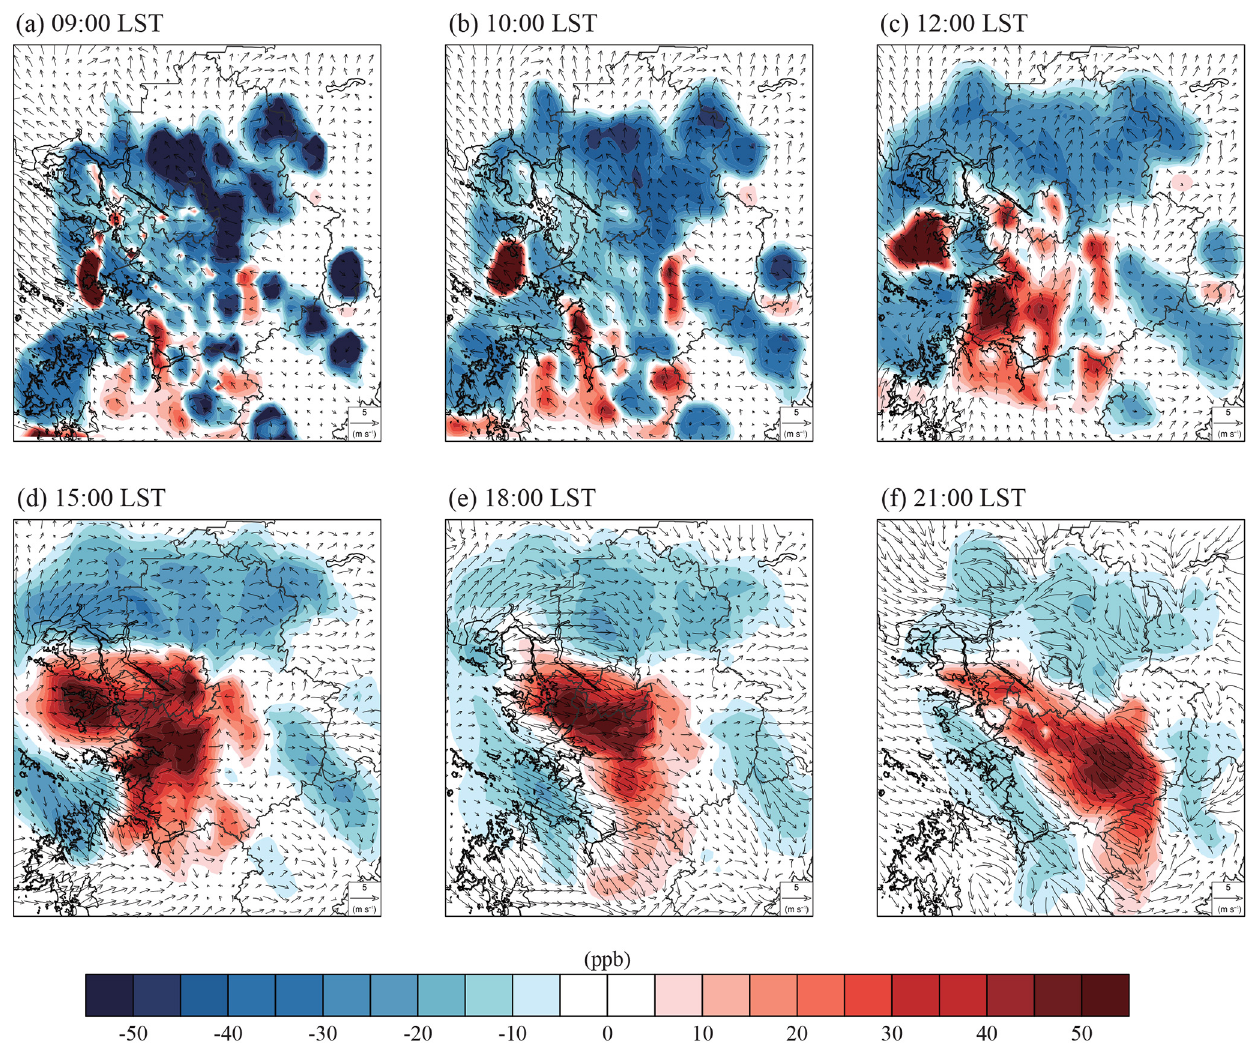
Figure 17. The same as Fig. 16 except that the contour value is analysis increments (a) and its impact on daytime ozone.